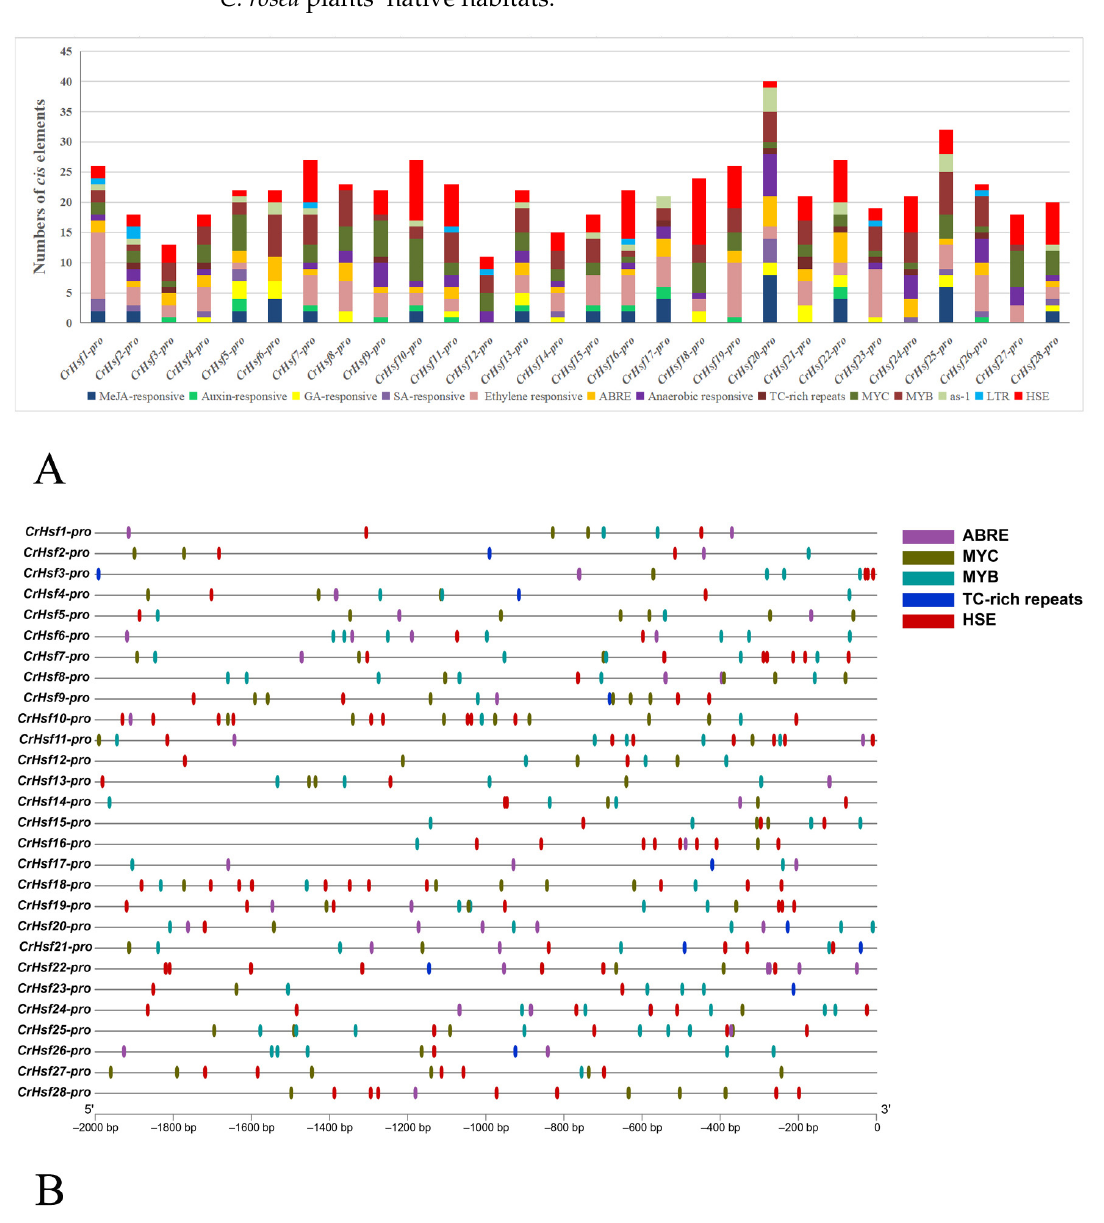
Figure 5. Prediction of cis -regulatory elements in the 2000 bp upstream regulatory regions of CrHsf genes: ( A ) Summaries of the thirteen cis -regulatory elements in the 28 CrHsf promoter regions; ( B ) distribution of the five cis -regulatory elements (ABRE, MYC, MYB, TC-rich repeat, and HSE) in the CrHsf genes promoter regions. The scale bar represents 200 bp.